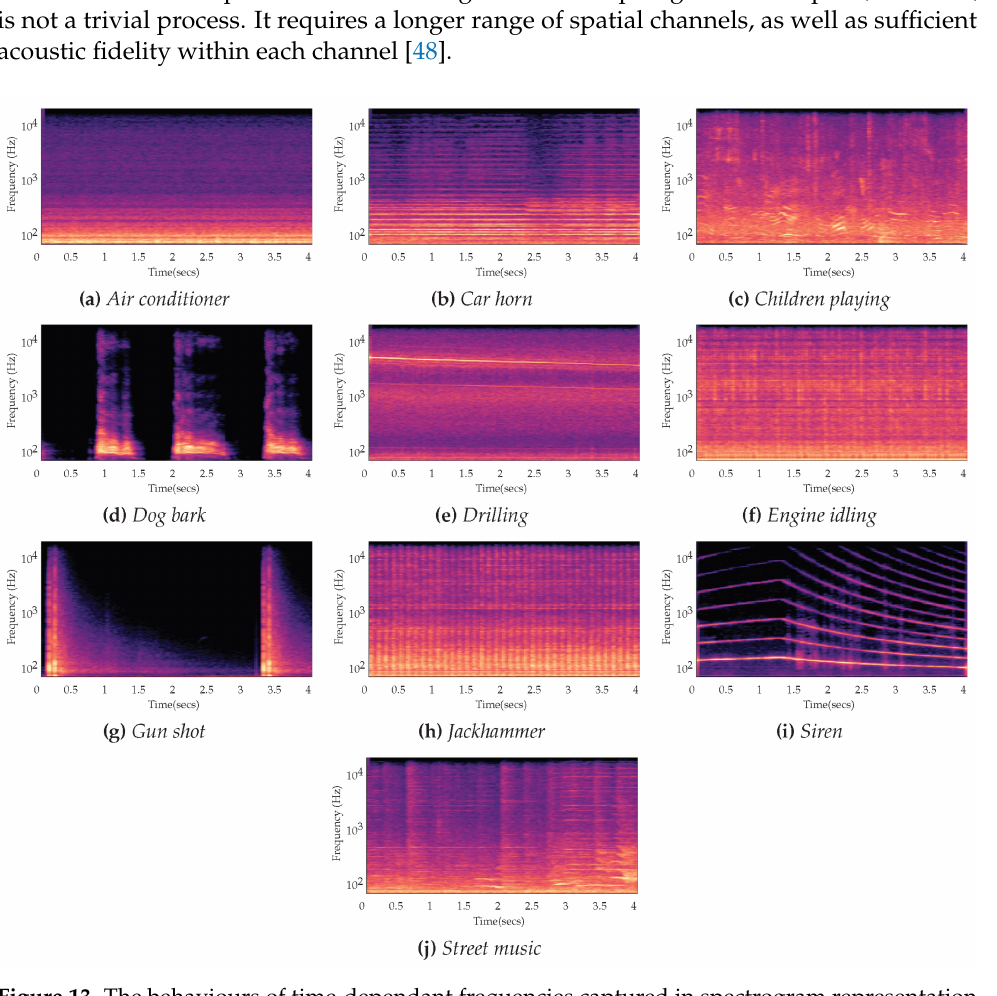
Figure 13. The behaviours of time-dependant frequencies captured in spectrogram representation from different classification schema. Reprinted from ref.